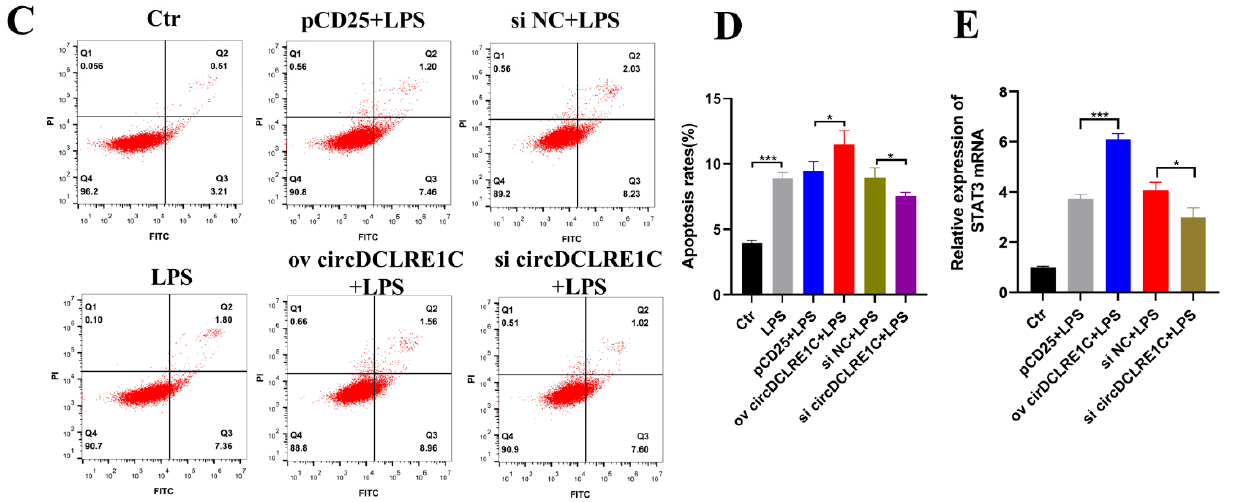
Figure 2. CircDCLRE1C aggravated LPS-induced inflammation and apoptosis in HD11 cells: ( A , B ) ELISA and qRT-PCR assay showing the expression levels of IL-6, TNF- α , and IFN- γ in HD11 cells with circDCLRE1C knockdown or overexpression. ( C , D ) Cell apoptosis measured with Annexin V–FITC/PI apoptosis detection kit via flow cytometry assay. ( E ) The mRNA levels of STAT3 in HD11 cells with circDCLRE1C overexpression and knockdown. Data are presented as means ± SD ( n = 3 biologically independent samples). * p < 0.05; ** p < 0.01; *** p < 0.001 (Student’s t -test).